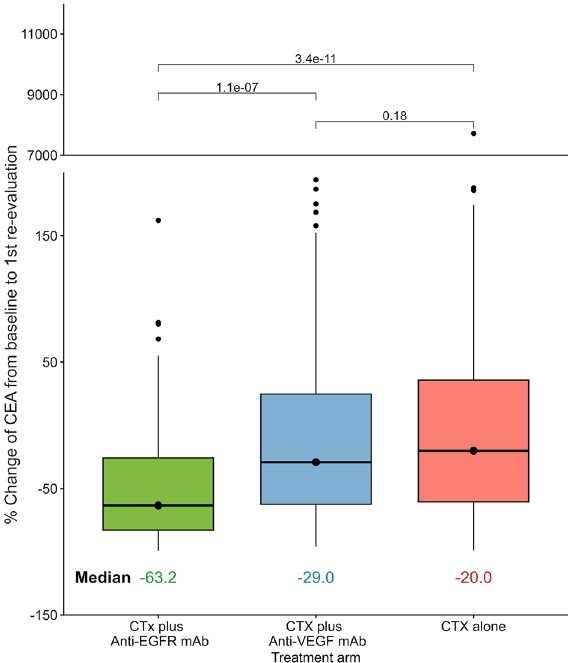
Figure 2. Boxplots of serum carcinoembryonic antigen (CEA) changes from baseline to the first response evaluation in patients without progressive disease (PD) according to treatment arm. CTX, chemotherapy; EGFR, epidermal growth factor receptor; VEGF, vascular endothelial growth